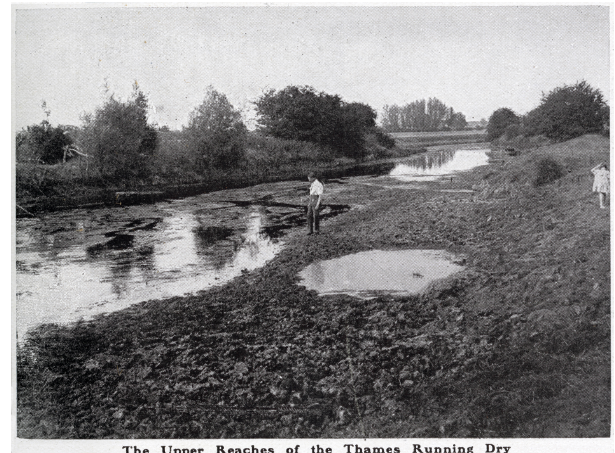
Figure A6. Photograph from the British illustrated newspaper The Sphere , 13 August 1921. The original caption is “The Upper Reaches of the Thames Running Dry. This picture was taken just above Lechiade in Glouchestershire. Usually at this time of year the river is very full of water. Now, however, it is nearly empty, and one can walk for long distances along what was formerly